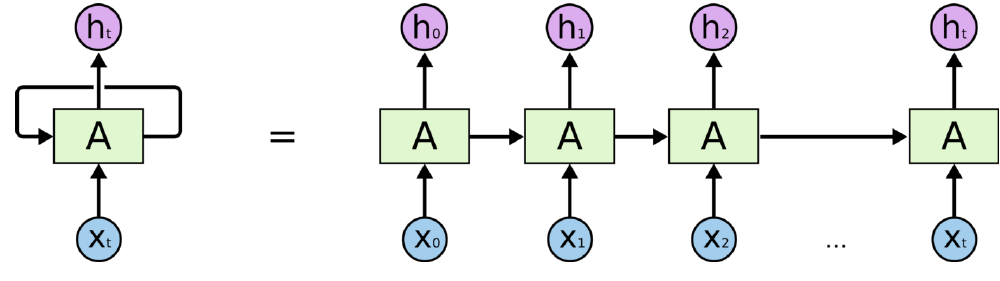
Figure 4. RNN Architecture